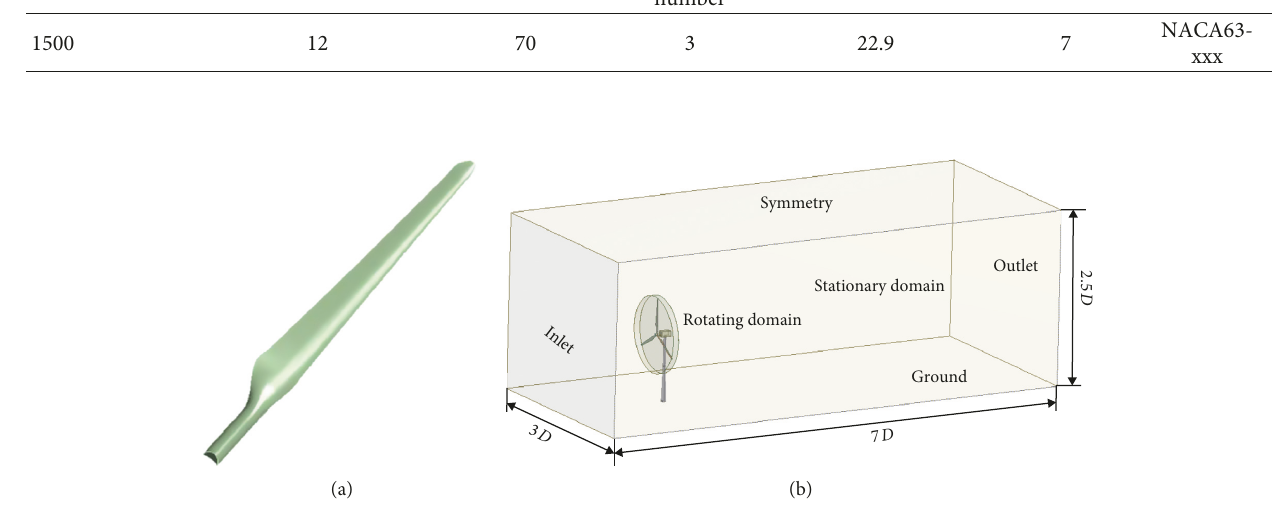
Figure 3: (a) Solid model of the blade. (b) Establishment of the fluid domain. Table 2: The grid-independent validation of the fluid domain and structural